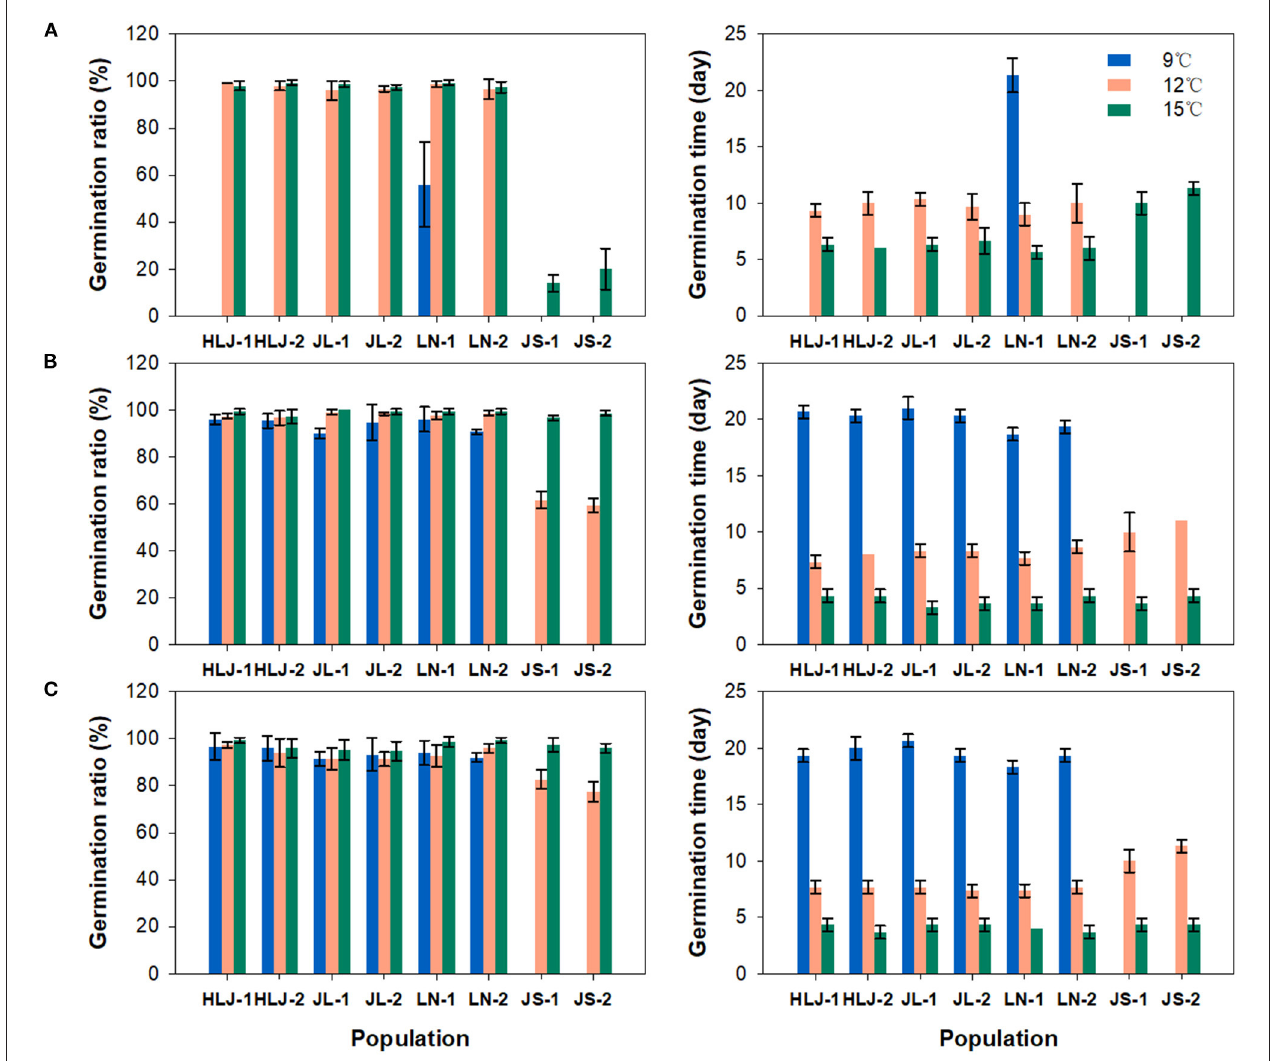
FIGURE 2 | Germination ratio (left) and germination time (right) of weedy rice seeds from 8 populations at 9, 12, and 15 ◦ C, respectively. Vertical bars indicate the standard error of the mean. Germination tests were conducted at 6 (A) , 12 (B) , and 24 (C) months after collection, respectively.